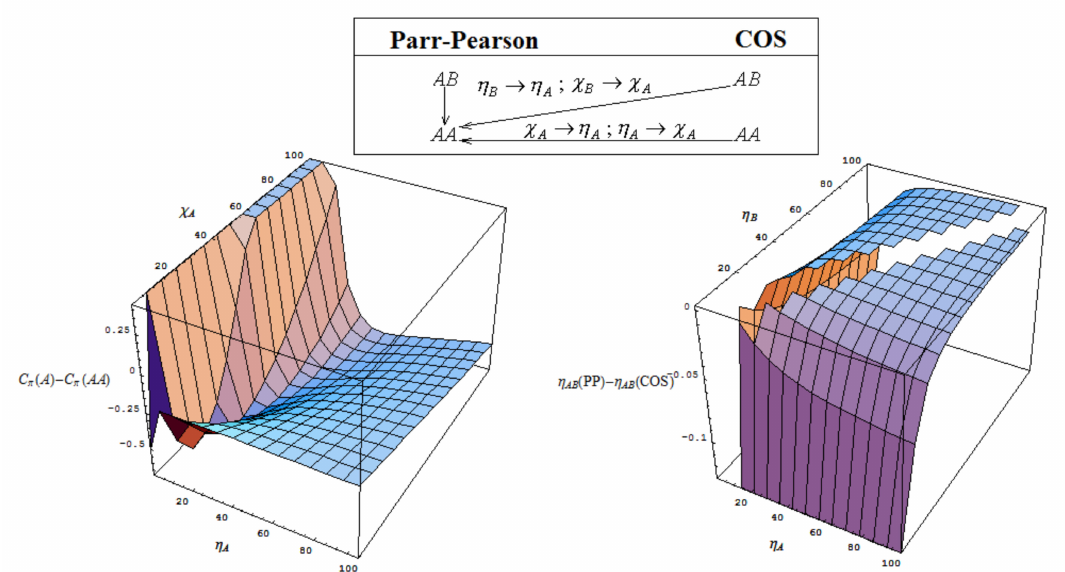
Figure 5. Top: synopsis of the COS to Parr–Pearson reduction; bottom-left: the chemical power difference of the isolated atom vs. atom-in-homonuclear bonding contribution; bottom-right: and the Parr–Pearson to COS chemical hardness difference for the AB bonding/molecule; all representations are made for equal unitary electronegativities χ A = χ B = 1, i.e., modeling the bonding upon electronegativity equalization consumption, upon the formulas from Table 1 and chemical power Equation (13), respectively; see text for